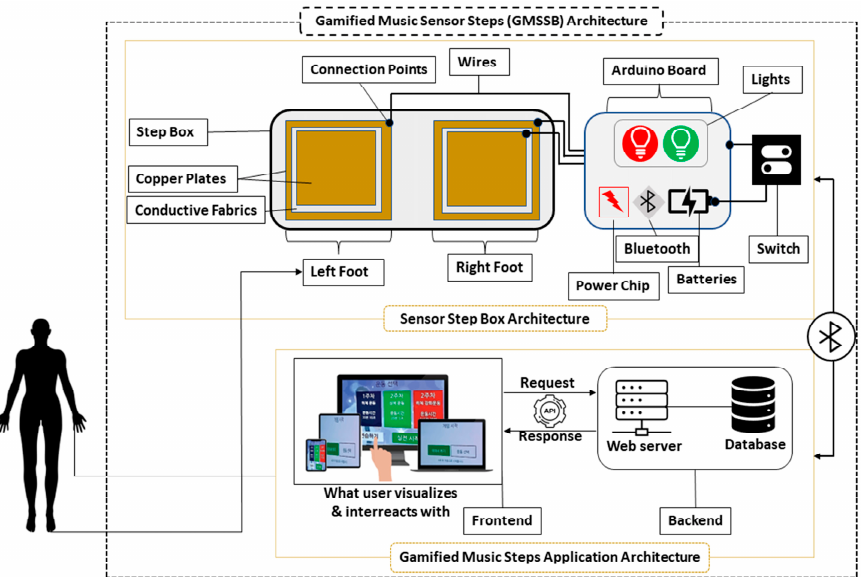
Figure 1. System architecture diagram of Gamified Music Sensor Step Box, showing the connectivity between SSB and “Gamified Music Steps” via Bluetooth.